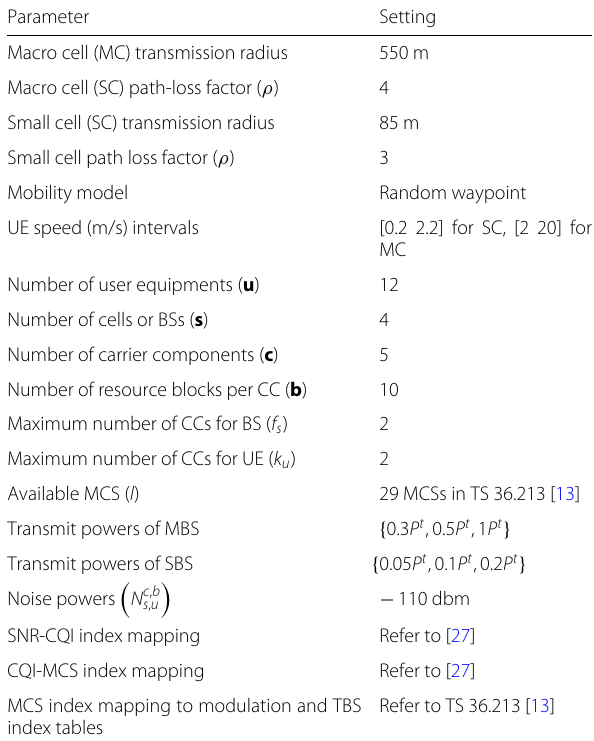
resource allocation. In addition to s = 4 and u = 3 just indicated, there are also c =5, b =10, l =29, and p =3,